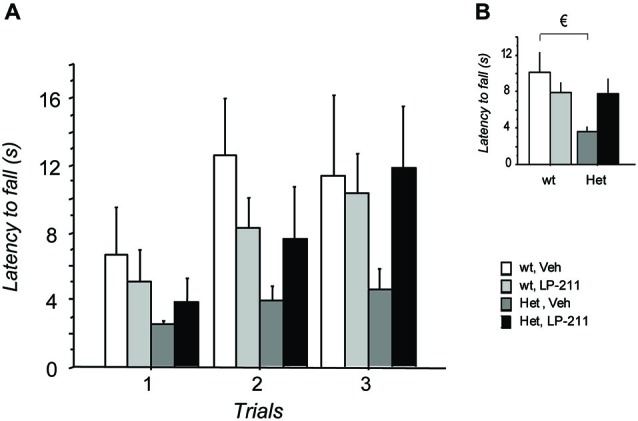
Treatment with LP-211 improves motor coordination capacities of MeCP2-308 female mice in the Dowel test. (A) In the Dowel test, MeCP2-308 female mice (Het, Veh) displayed significantly shorter latencies to fall compared to wt controls (wt, Veh), confirming impaired motor coordination capacities. LP-211 improved the performance of Het mice in this test. Three trials per mouse were performed, with an intertrial interval of at least 15 min. (B) Data from the three trials were pooled to highlight significant differences between the experimental groups. Mice for each condition were as follows: wt, Veh = 9; wt, LP-211 = 11; Het, Veh = 12; Het, LP-211 = 10. Data are mean ± SEM. € : wt, Veh vs. Het, Veh, p < 0.05.